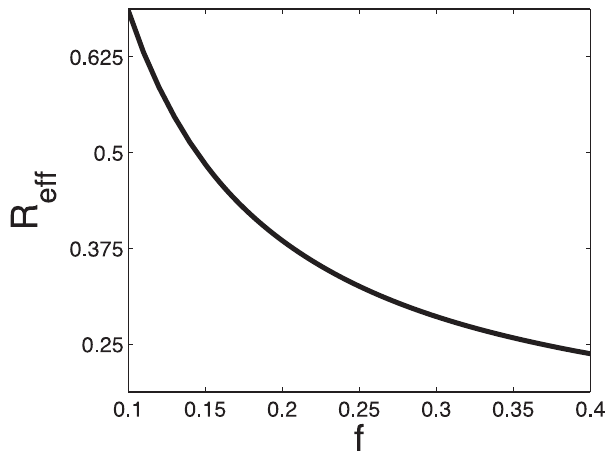
Figure 4. Effective resistance of a 5-level M-tree. The resistance and its derivative are decreasing functions of the OTR. The values in the ordinate are normalized by the resistance of a capillary